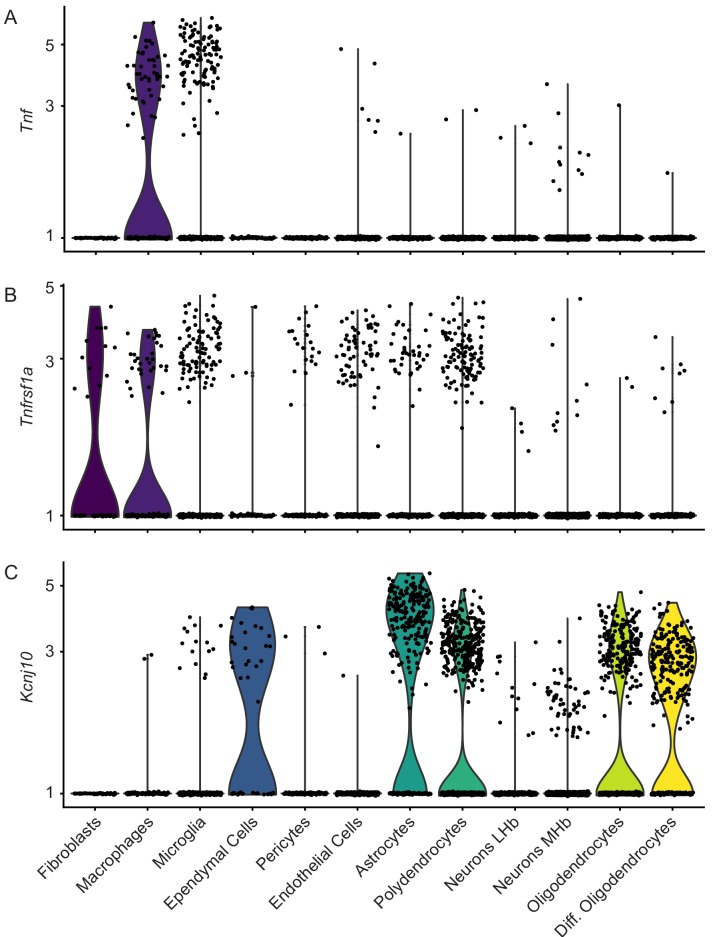
Expression of genes known to be important for habenular microglial and astrocytic function.Violin plots of gene expression (scaled and log normalized) for Tnf (A), Tnfrsf1a (TNF-receptor) (B), and Kcnj10 (Kir4.1) (C). Each point represents a single cell and the filled area is a probability distribution of all the cells in that category.